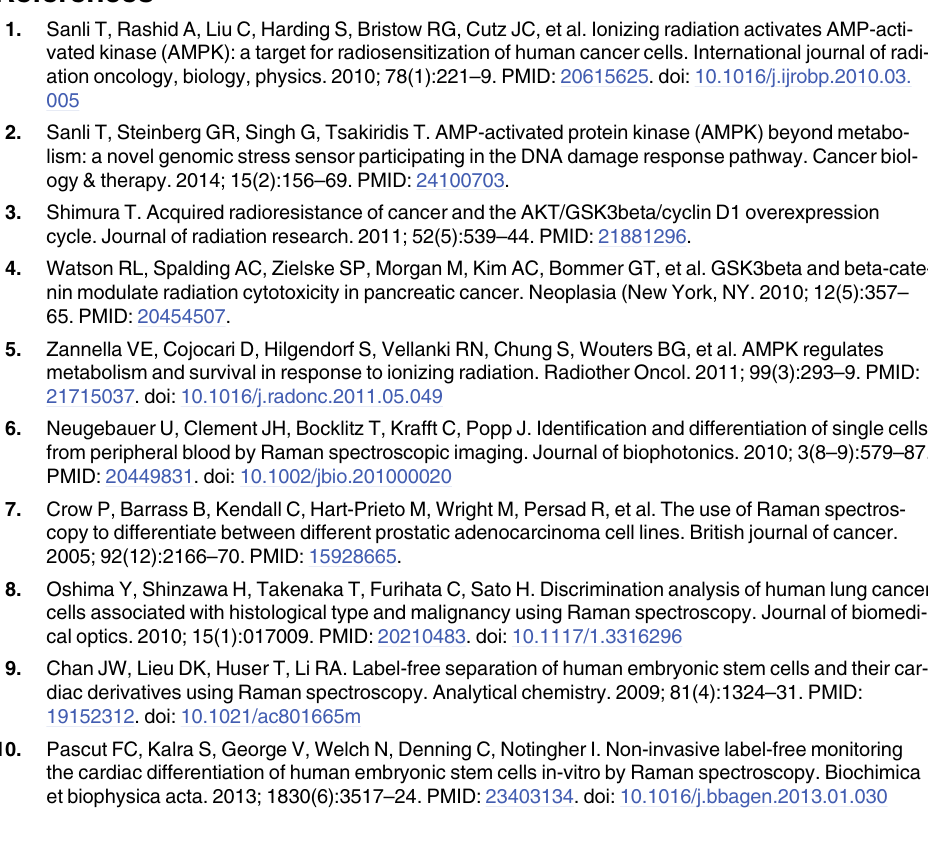
antibodies. Results are the mean ±SE from two independent experiments. (TIFF) S4 Fig. Cell cycle distributions for radiation and metformin co-treated H460 and MCF7 cells determined via propidium iodide flow cytometry. ( a & b ) G1/G0-phase fractions for ( a ) H460 and ( b ) MCF7 cells, and ( c & d ) G2-phase fractions for ( c ) H460 and ( d ) MCF7 cells were measured in triplicate at 3-days post-irradiation. Values are the mean ±SE from 3 inde- pendent experiments. (cid:1)(cid:1) p < 0.01 (unpaired two-tailed t-test).